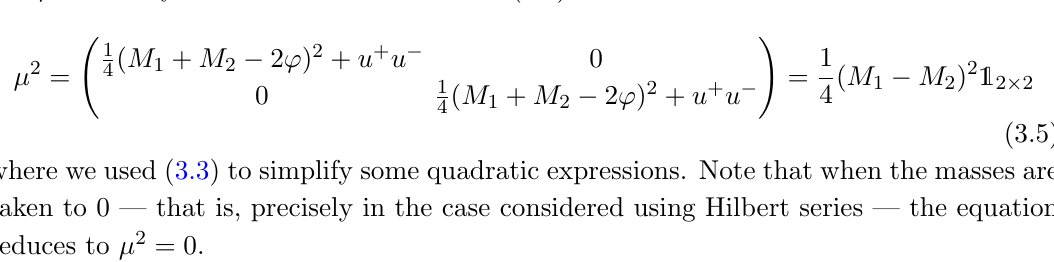
Figure 3 . Quiver with sl (3 ; C ) isometry of the Coulomb